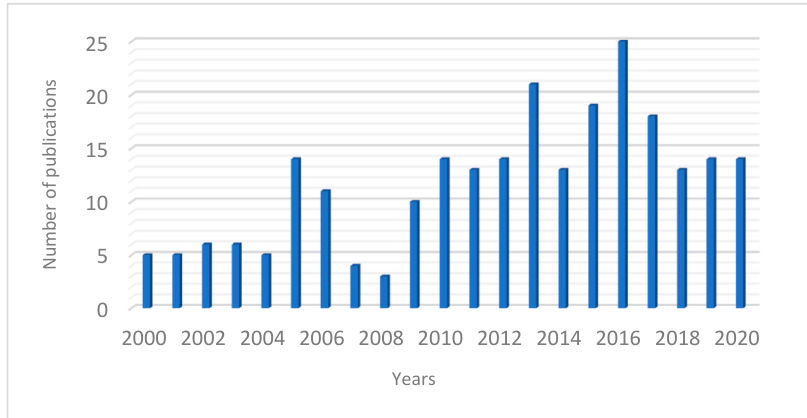
Figure 2. Papers published per year. Source Scopus (31 October 2020), key words “lactams” and “medicinal